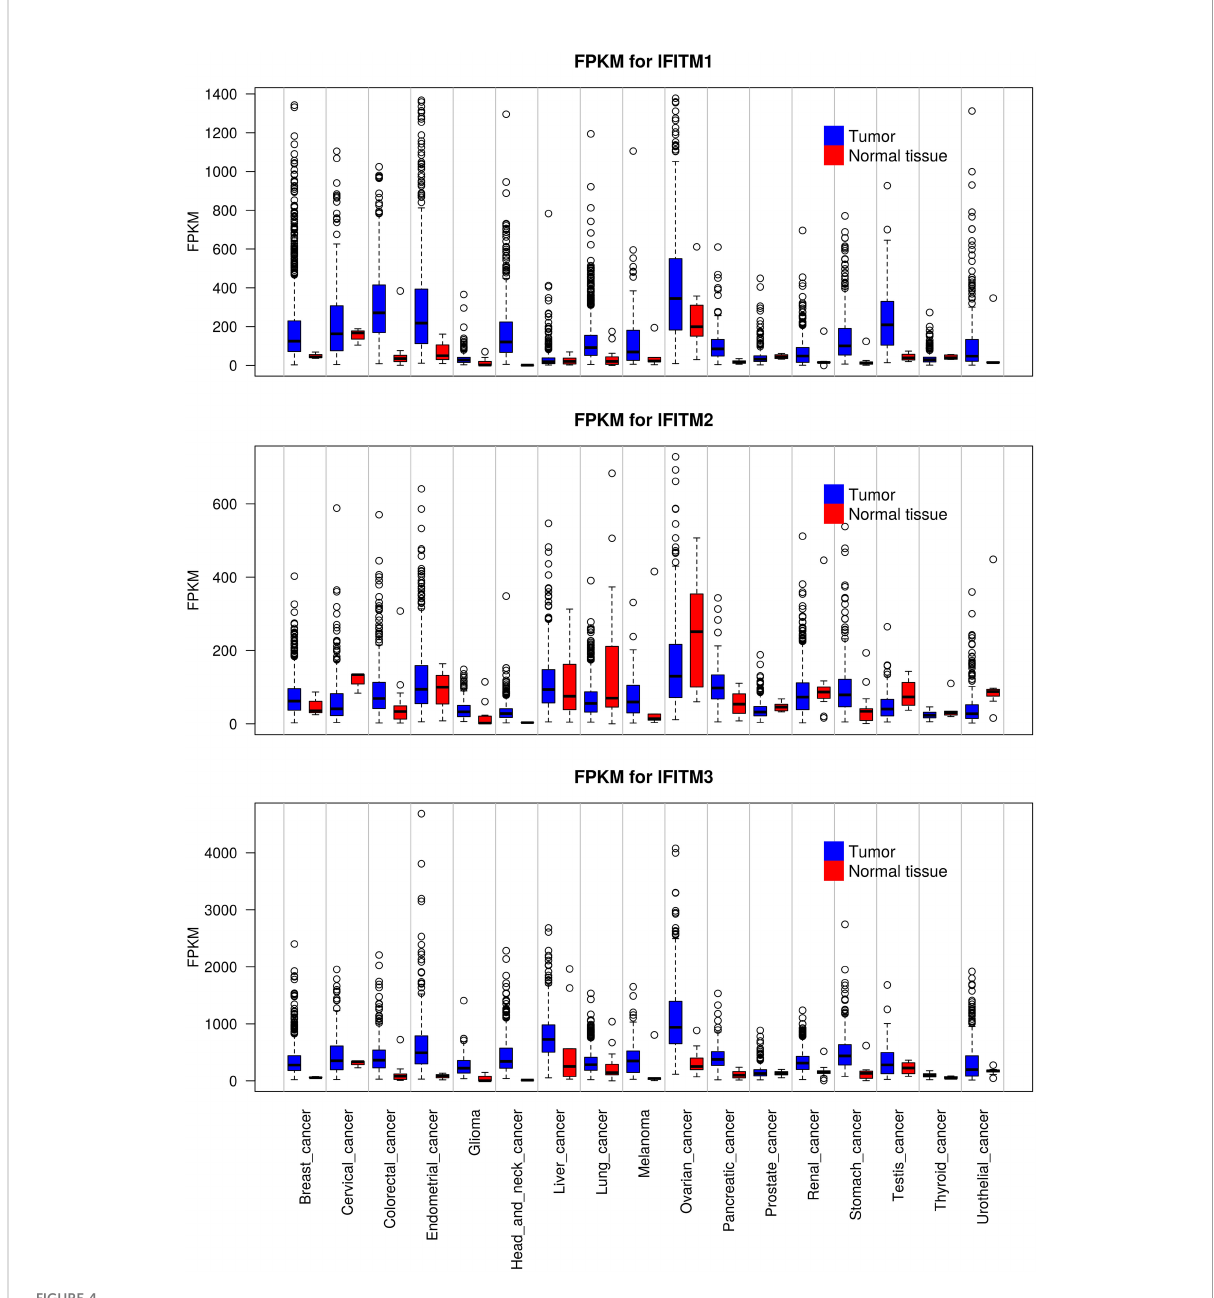
FIGURE 4 Expression levels of IFITM1, IFITM2 and IFITM3 in different types of tumors compared with adjacent normal tissue. The data used for the analyses were obtained from the GTEx Portal (https://gtexportal.org/home/) on 06.09.2021. The obtained data set was processed using Rscript, which is based on the R language (https://www.R-project.org/), and box plots of the IFITM genes were created. FKPM - fragments per kilobase